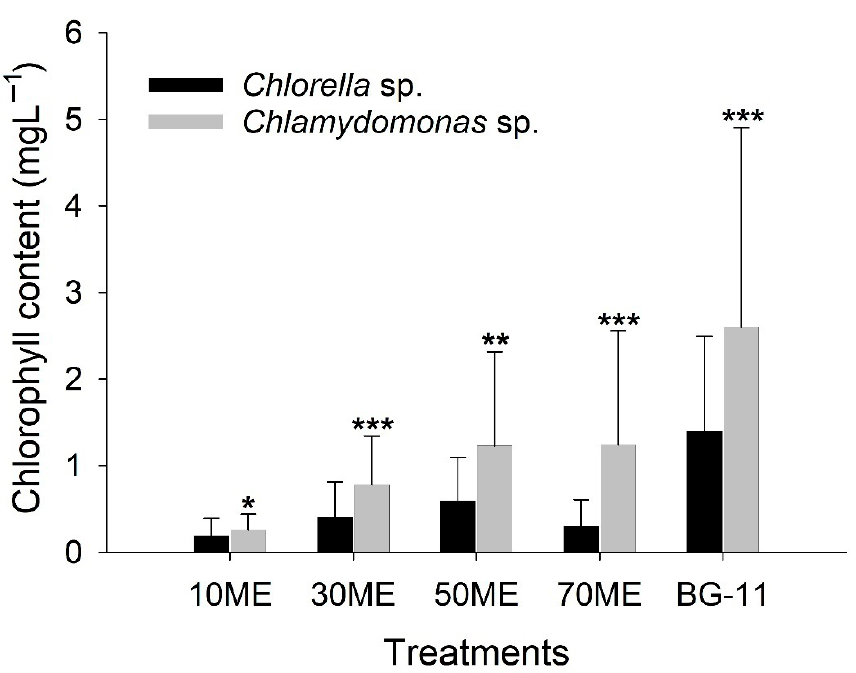
Figure 8. Variation of chlorophyll content between Chlorella sp. and Chlamydomonas sp. cultivated in different dilution concentrations of malting effluent and standard mineral media (BG-11). The bars (black bars: Chlorella sp. and grey bars: Chlamydomonas sp.) represent mean lipid content and errors refer to standard deviation. The level of significance is from two-sample t -test statistics (* p < 0.05, ** p < 0.01, *** p < 0.001).